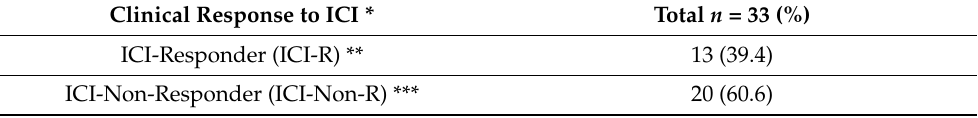
Table 3. Responder and Non-Responder patients according to their clinical responses to ICI.